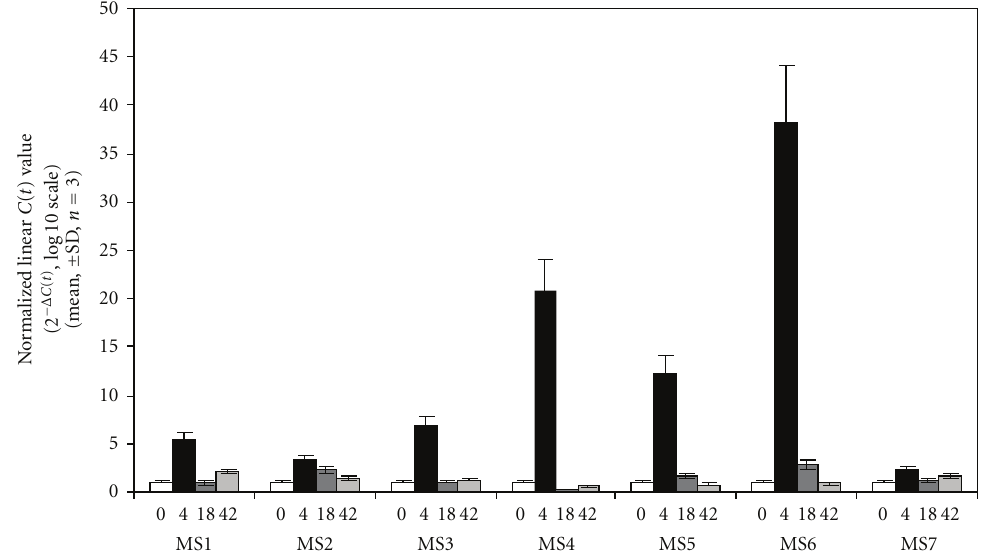
Figure 5: Confirmationof RGS1 GeneChip expression data using RT-PCR . The sameRNA obtained fromMS patients treated with Betaseron and used for the GeneChip study was used to independently validate the expression of RGS1 using RT-PCR. RGS1 expression wasdetermined using RT-PCR (TaqMan custom primer set Hs00175260 m1) at 0, 4, 18, and 42 hours post-Betaseron administration. MS 1–7 refers to MS patients included in the initial study. Data are expressed as linearized C ( t ) values normalized to GAPDH. Data are presented as the mean ± SD ( n = 3).